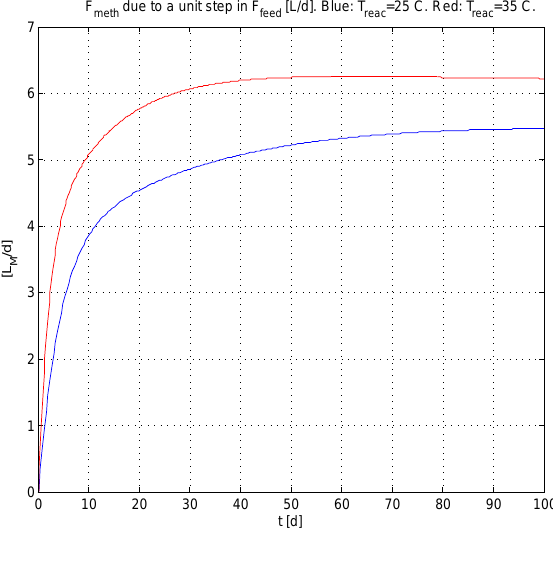
Figure 13: ∆ F meth ( t ) due to a step change of F feed of amplitude 1 L/d at T reac = 25 o C and 35 o C.